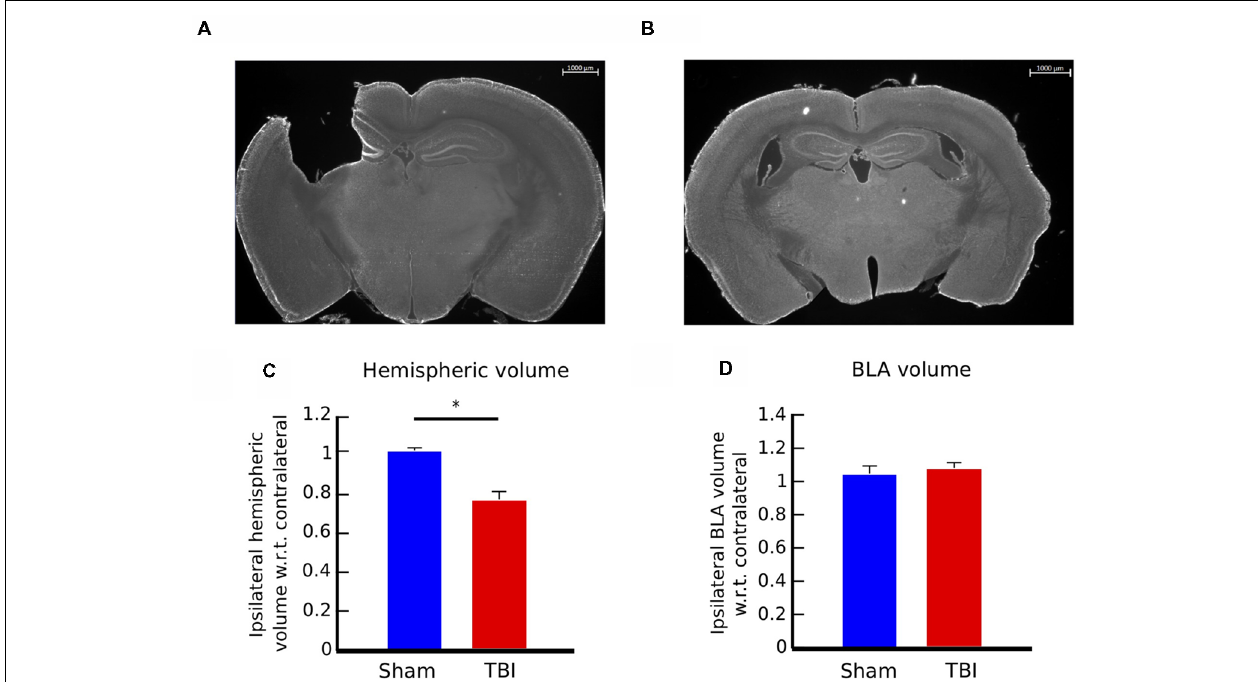
FIGURE 3 | Controlled cortical impact (CCI) causes consistent injury across animals and no volumetric change in the basolateral amygdala (BLA). (A) 12 × panoramic coronal sections stained with Fluoro Nissl, representing the lesion in the cortex and hippocampus for TBI animals and (B) intact areas in sham controls. (C) Hemispheric volume in TBI and sham animals. There is a significant reduction in the ipsilateral hemisphere volume of injured animals, compared to sham controls ( t -test, p < 0.05). (D) Volumetric measure of the BLA. Injury does not cause volumetric change in the BLA of TBI animals. Bar graphs in (C,D) show mean ± SEM of data from n = 10 mice in the TBI condition and n = 10 mice in the sham condition after removal of outliers (“Materials and Methods” section); the number of outliers did not exceed one mouse for any condition; ∗ p <